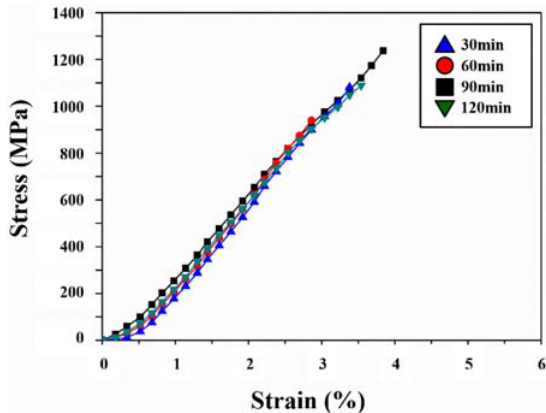
Figure 10. The strain ‐ stress curve of the austempered specimens (1080 °C ‐ 30 min) with a salt ‐ bath temperature of 300 °C and different salt ‐ bath times.